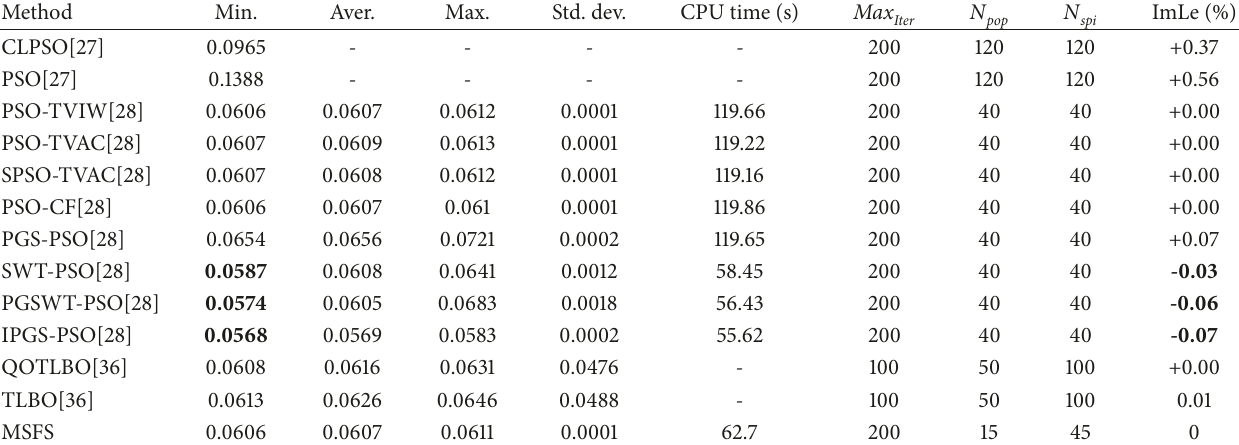
Table 10: Comparison of results obtained from IEEE 118-bus system with L-index